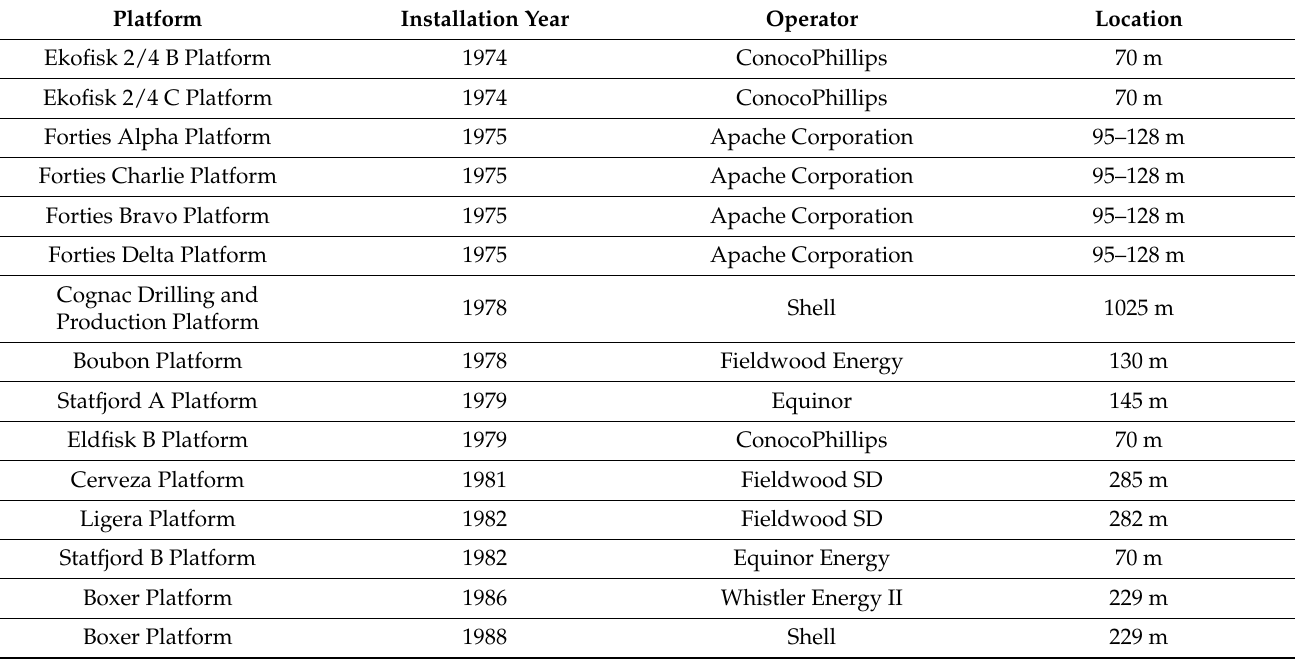
Table 2. Sustainable maintenance management found on offshore structures that are among the longest standing fixed offshore